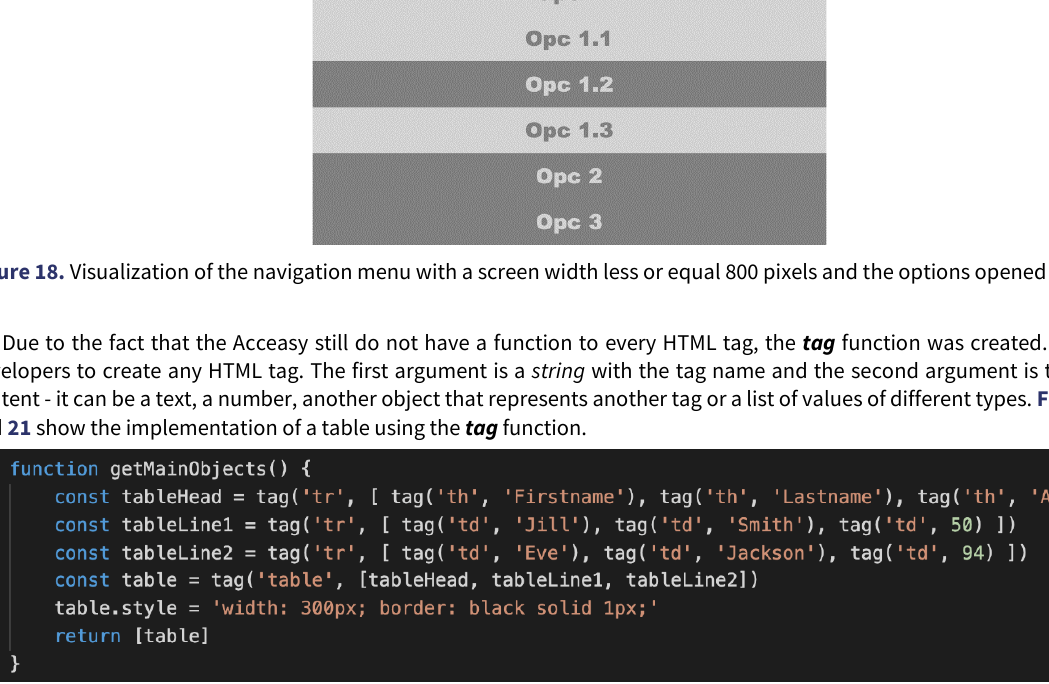
Figure 19. Implementation of the getMainObjects function to create a table using the tag function